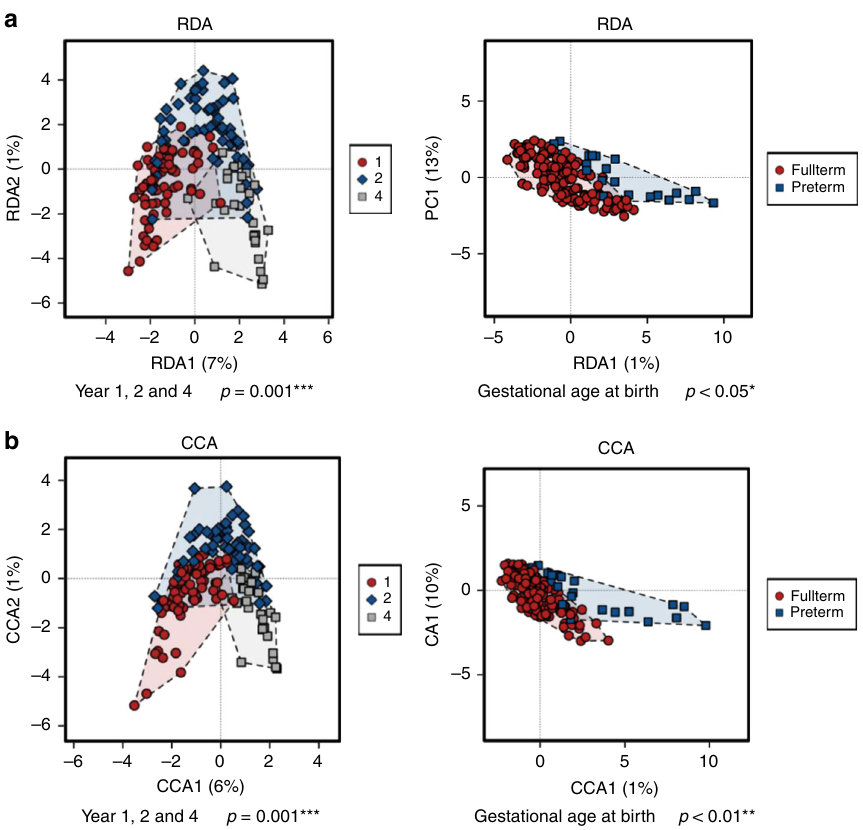
Fig. 1 Samples separate based on year and gestational age at birth. a Redundancy analysis (RDA) of operational taxonomic units (OTUs) (top 1000 OTUs present) showing separation of samples by year. b Canonical correspondence analysis (CCA) on OTUs, with samples shown at year one, two and four. Source data are provided as a Source Data fi le. (* p < 0.05, ** p < 0.01, *** p <